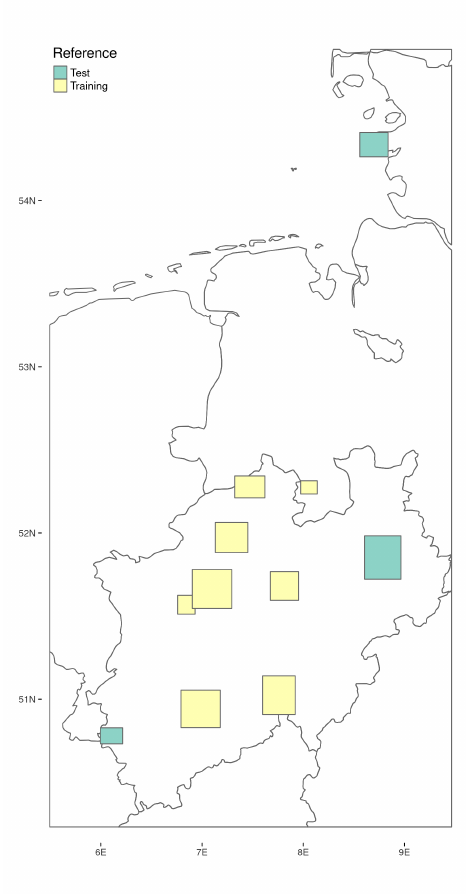
Figure 2. Study Area, The most northern test area is depicted in more detail in Figures 3 and 4